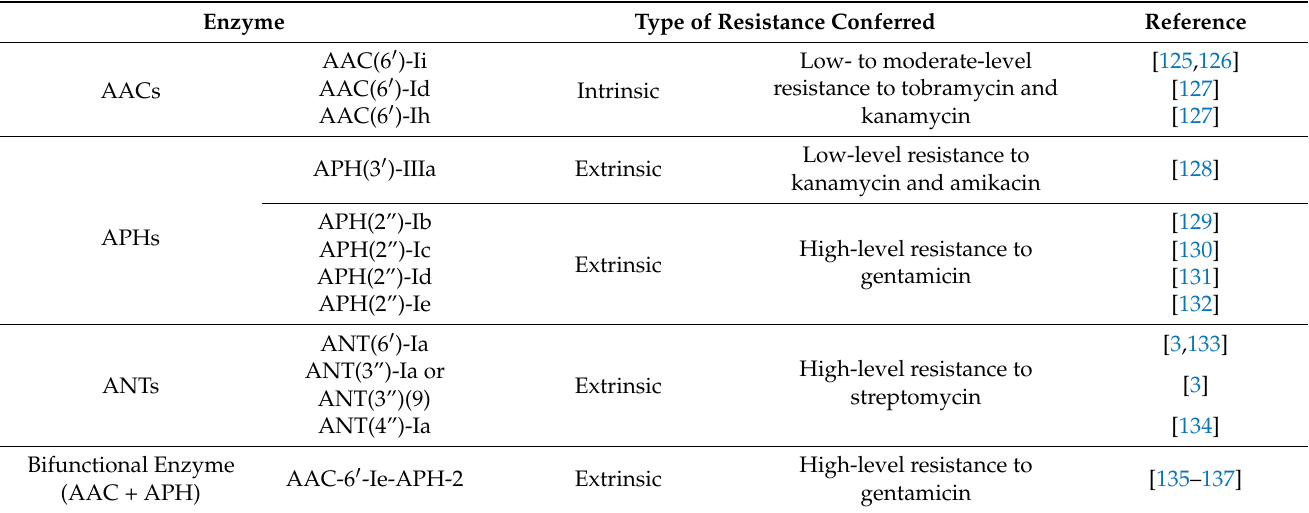
Table 1. Representation of all of the aminoglycoside-modifying enzymes that have been described in the Enterococcus genus, along with the type of resistance presented and the respective